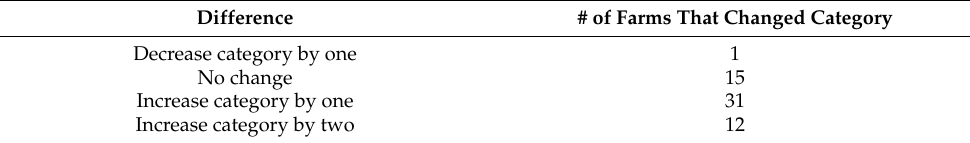
Table 7. The difference in classification between April 2013 and April